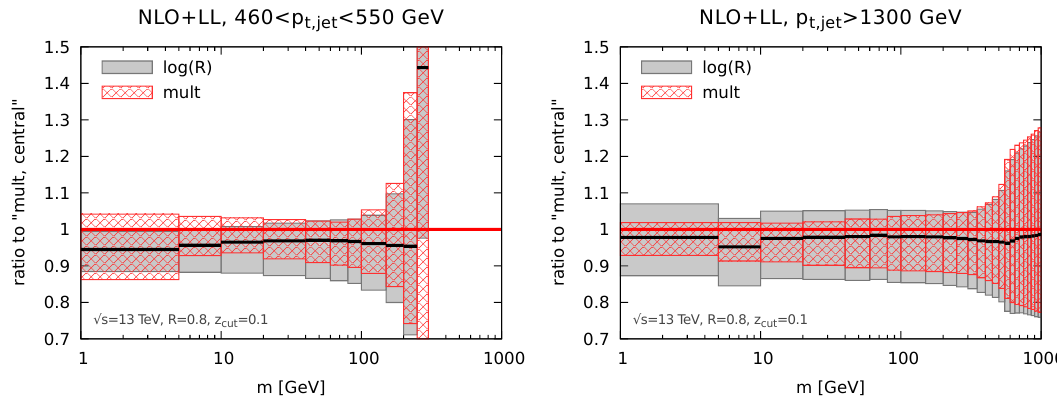
Figure 4 . Comparison of the jet mass distribution in two di(cid:11)erent matching schemes, the multi- plicative one eq. (3.17) and the log- R one eq.